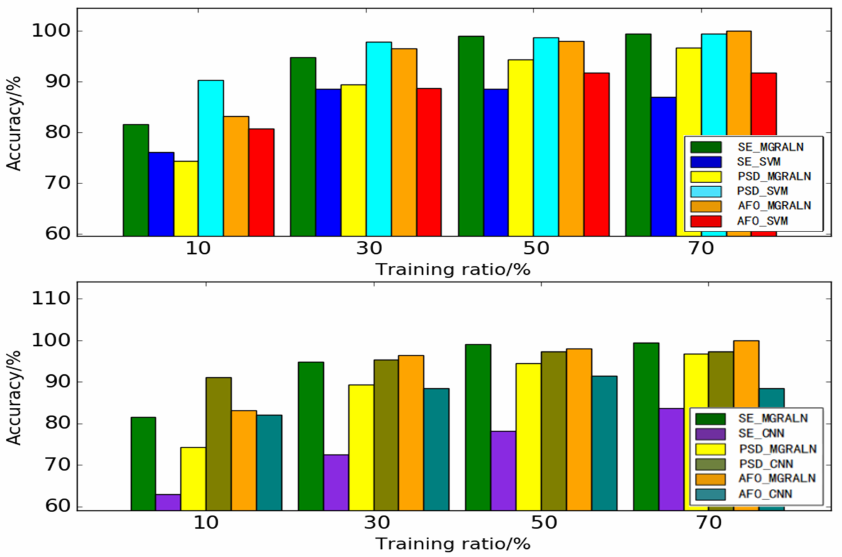
Figure 8. The accuracy performance of MGRALN when K = 2 with SVM and CNN